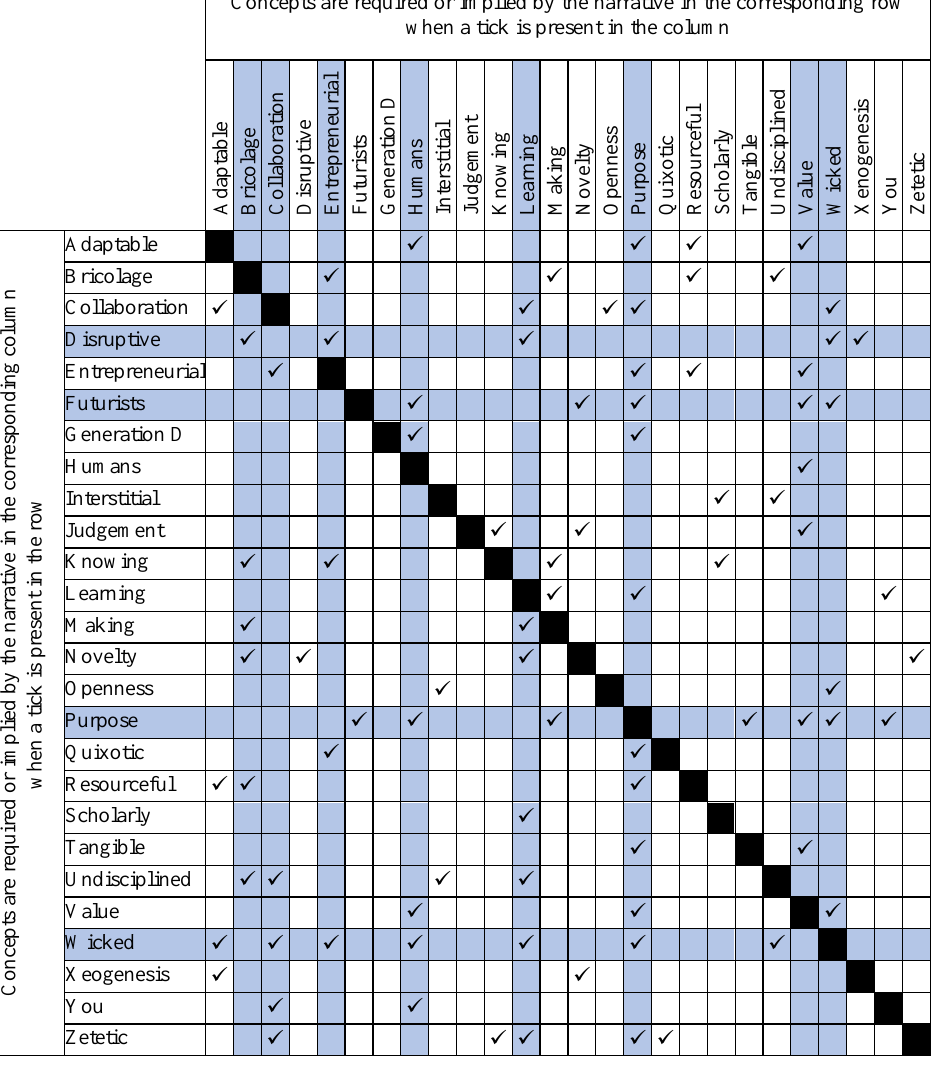
Figure 2. Concept Relationship